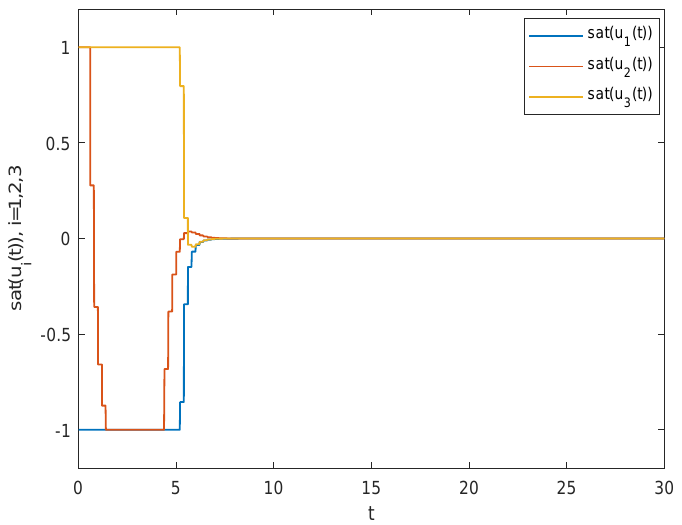
Figure 6. Schematic of the saturated aperiodic SD controller sat ( u ( t )) of Example II.